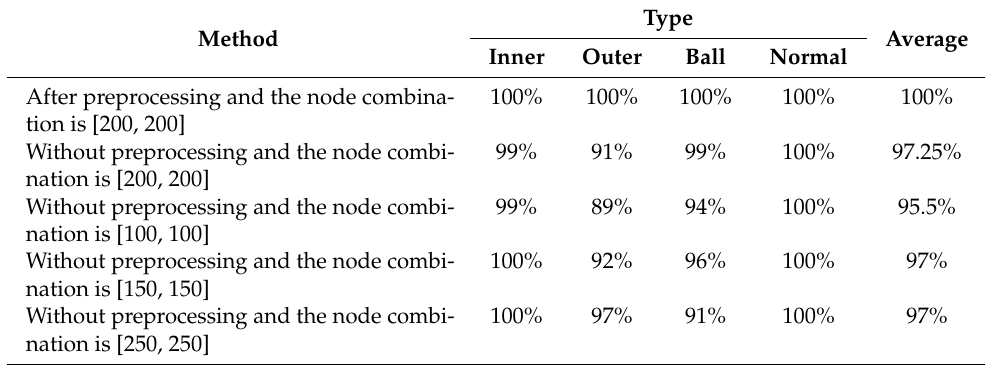
Table 5. Average classification accuracy of the DBN model under various conditions. Type Method Average Inner Outer Ball Normal After preprocessing and the node combina- 100% 100% 100% tion is [200, 200] 99% Without preprocessing and the node combi- nation is [200, 200]